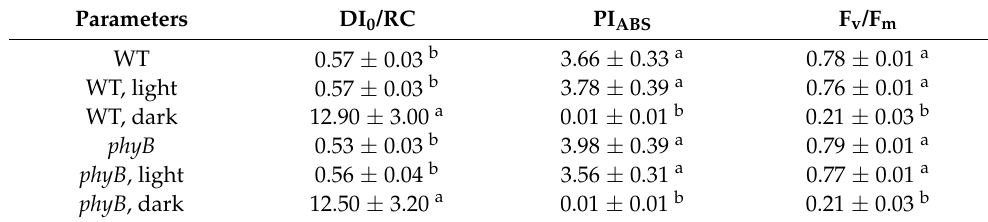
Figure 2. Effect of 2 h of heat treatment on fluorescent parameters (F v /F m ( A ), DI 0 /RC ( B ), and PI ABS ( C )) and rates of photosynthesis (P N ) ( D ) and respiration (R) ( E ) in wild type (WT) and phyB mutants. Plants were grown in tops and kept for 2 h at 40 °C in the dark (WT and phyB , dark) and in the light (WT, and phyB , light) compared with the initial variants at 21 °C. Mean values ± SD are shown ( n = 4). Different letters correspond to a significant difference in values at p < 0.05. With lincomycin, a significant increase in DI 0 /RC was observed only for the phyB mutant. At 1 h of heat exposure, a significant decrease in PSII activity (PI ABS ) was observed only for the phyB mutant. Moreover, when keeping the mutants and WT at 40 °C in the dark, the decrease in PSII activity was more significant than in the light. Moreover, we (Figure 2). The most significant changes in the parameters were also in the phyB mutant. ters, the response of PSII to heating was the same in both WT and phyB mutants (Table 1). Table 1. Effect of heat treatment on fluorescent parameters in wild type (WT) and phyB mutants grown under white light (130 µ mol (photon) m − 2 · s − 1 , photoperiod 12 h). Plants were grown in tops and kept for 6 h at 40 ◦ C in the dark (WT, dark and phyB , dark) and in the light (WT, light and phyB , light) and compared to the initial variants at 21 ◦ C. Mean values ± SD are shown ( n = 4). Different letters correspond to a significant difference in values at p < 0.05. Here, F v /F m is maximal quantum yield of PSII photochemistry, DI 0 /RC is the quantum yield of energy dissipation, and PI ABS is the PSII performance